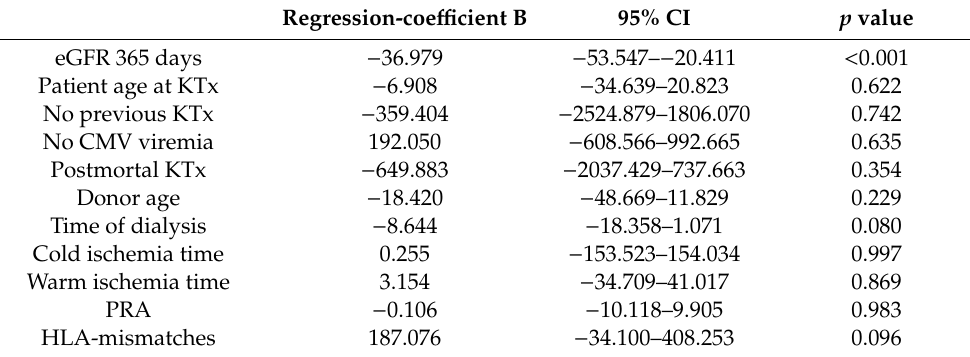
Table 6. Multivariable linear regression model for GDF15 one year after